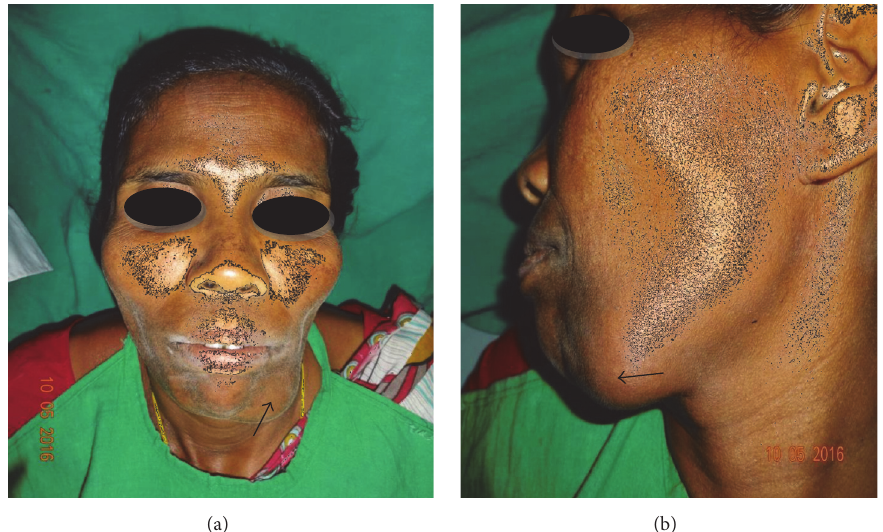
Figure 1: (a, b) Swelling in the left lower side of the mandible.